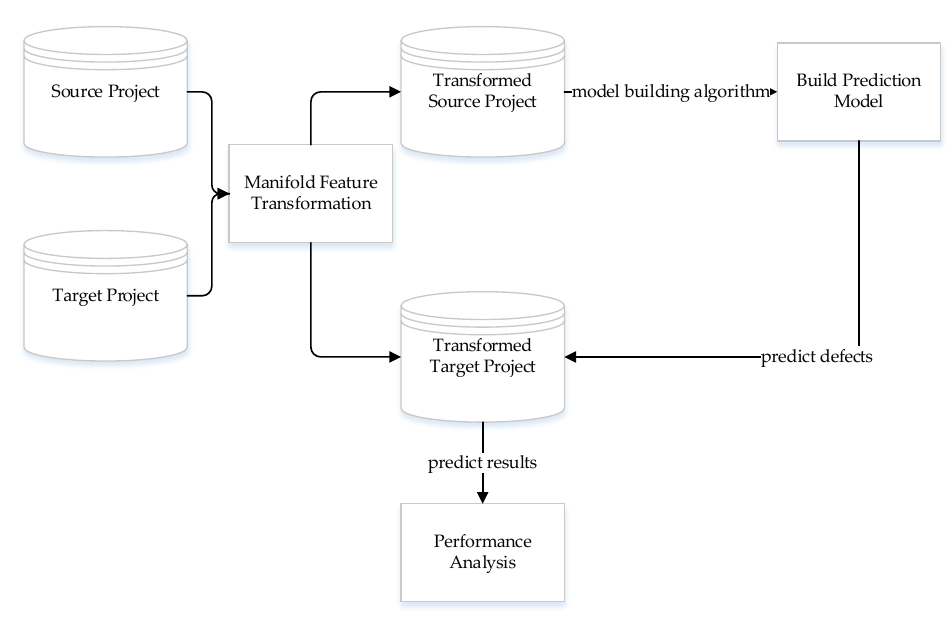
Figure 1. MFTCPDP method framework.